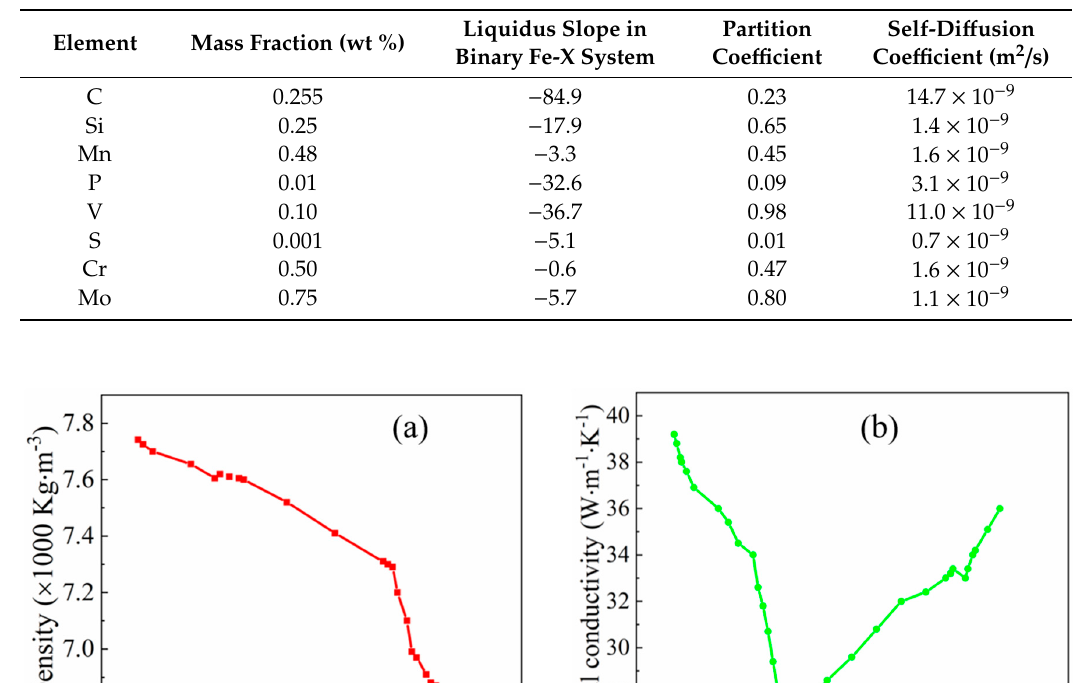
Table 1. Element contents and physical parameters of 26CrMoVTiB.